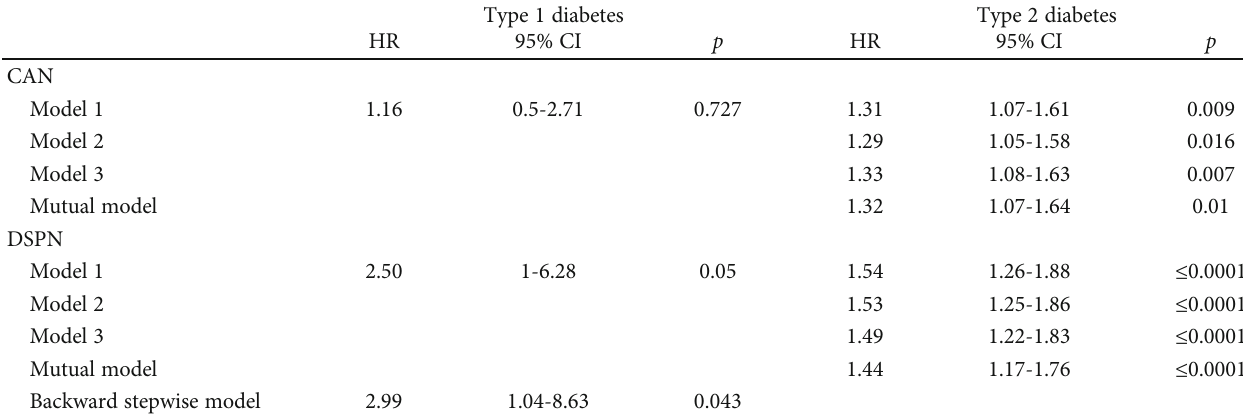
Table 2: The association between CAN and DSPN (Cox proportional hazard